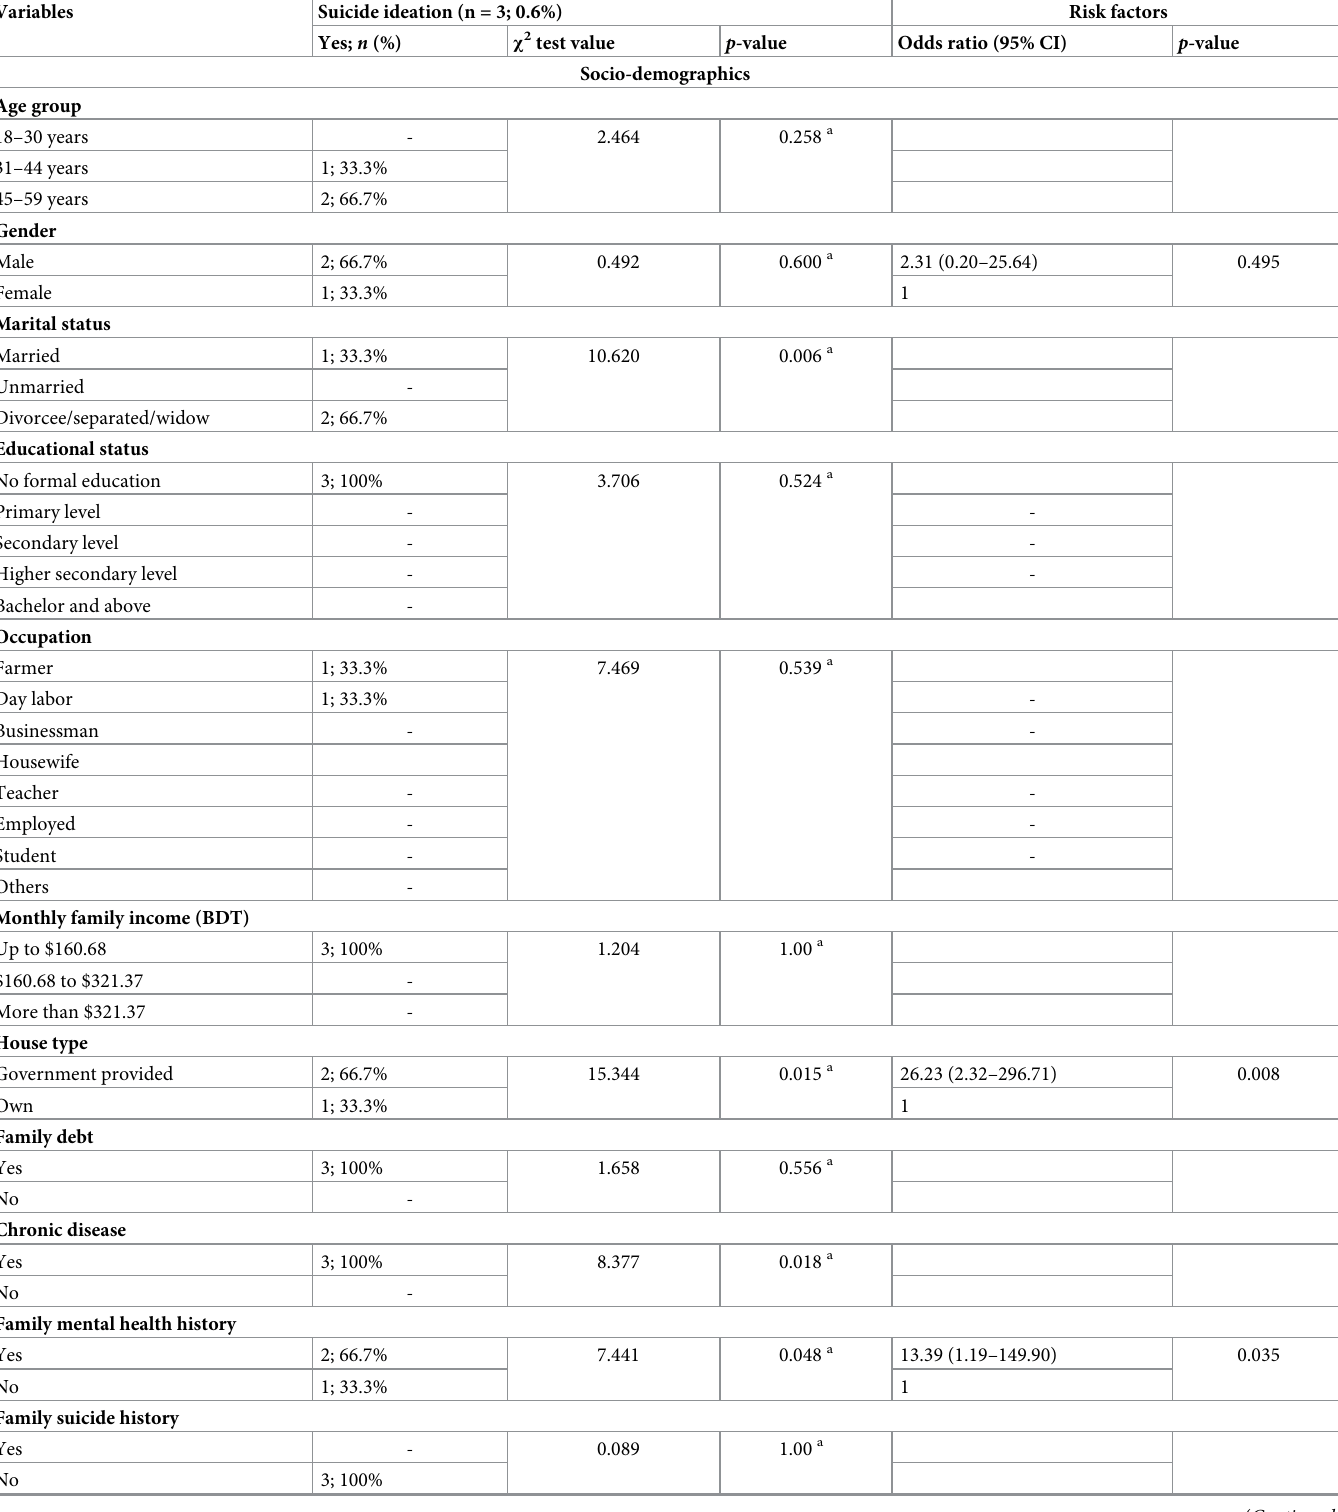
Table 4. Association between the study variables and past-month suicide ideation and its associated